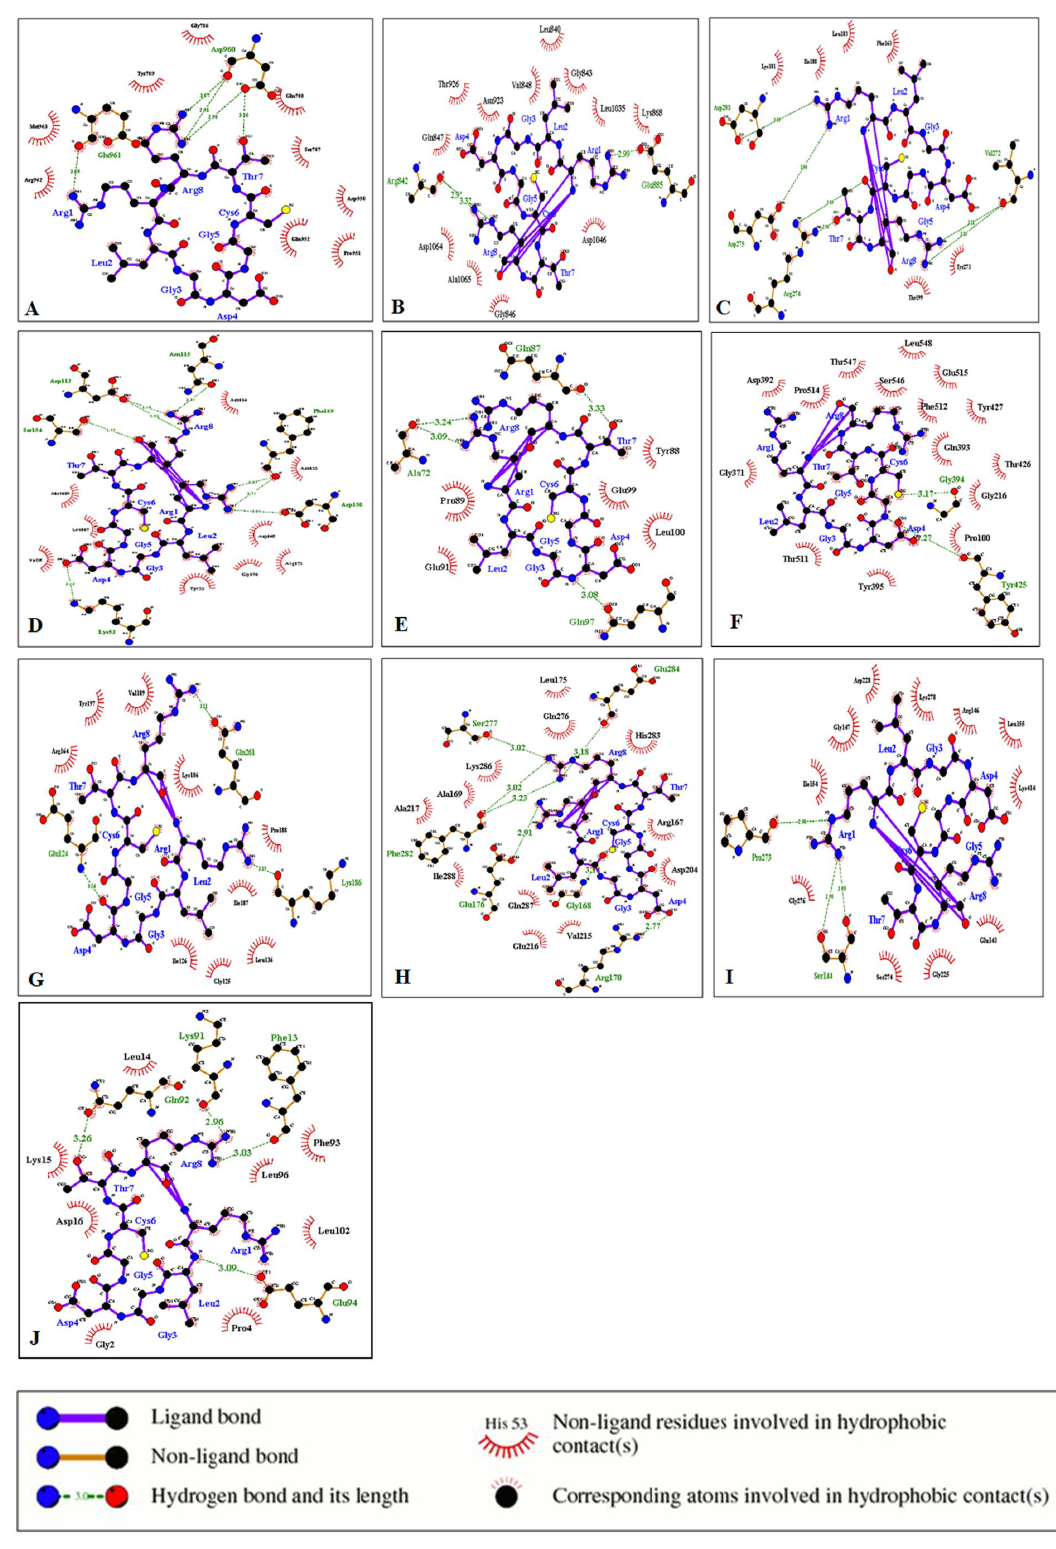
Figure 5. Interaction of cyclosaplin with various cancer-related proteins. ( A ) EGFR Kinase. ( B ) VEGFR2 Kinase. ( C ) PKB. ( D ) p38. ( E ) PTEN. ( F ) MMP-2. ( G ) Procaspase 3. ( H ) Procaspase 7. ( I ) Caspase 9. ( J )